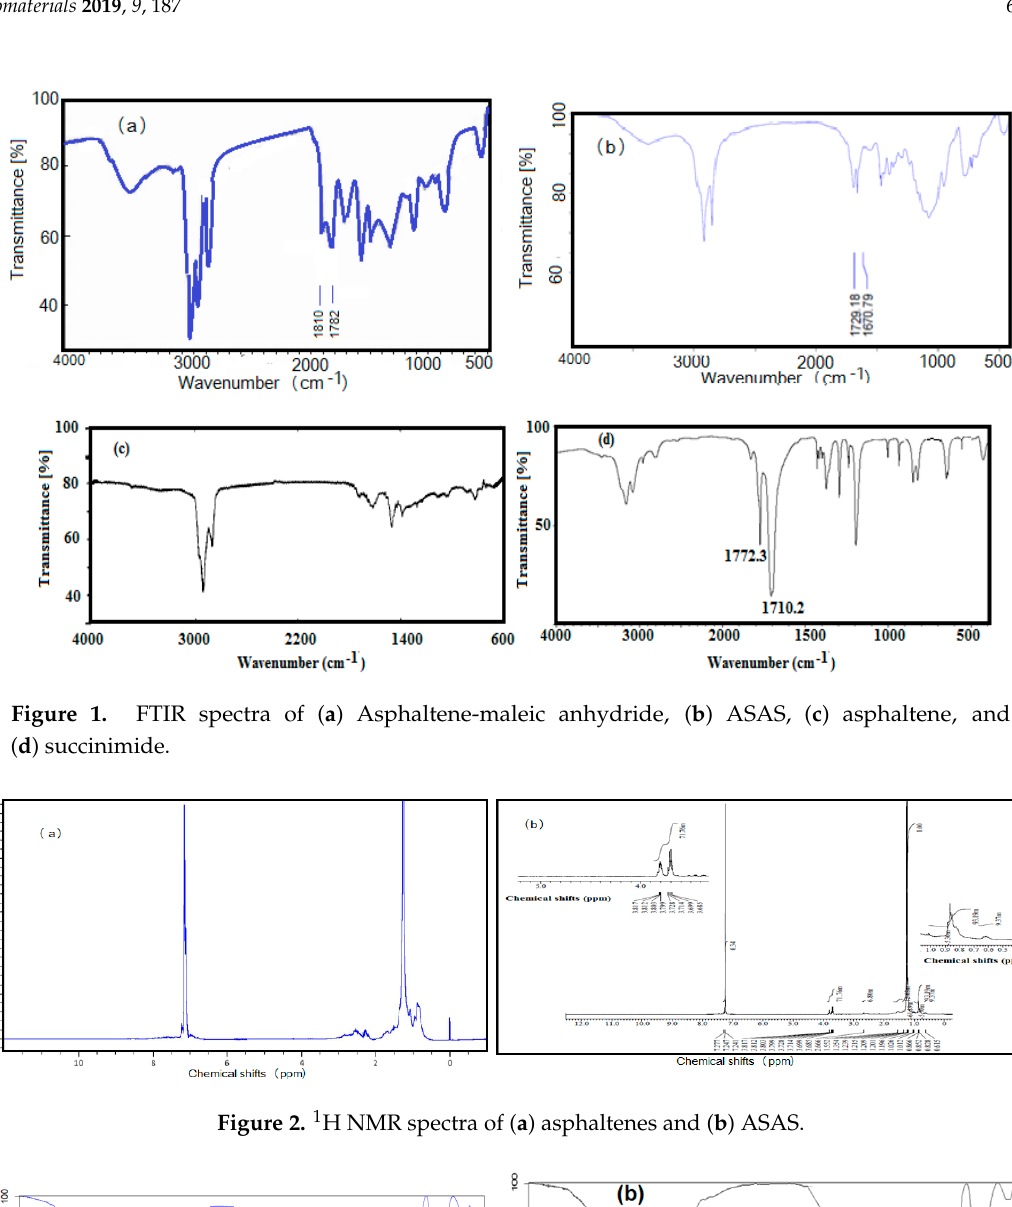
Figure 2. 1 H NMR spectra of ( a ) asphaltenes and ( b ) ASAS.